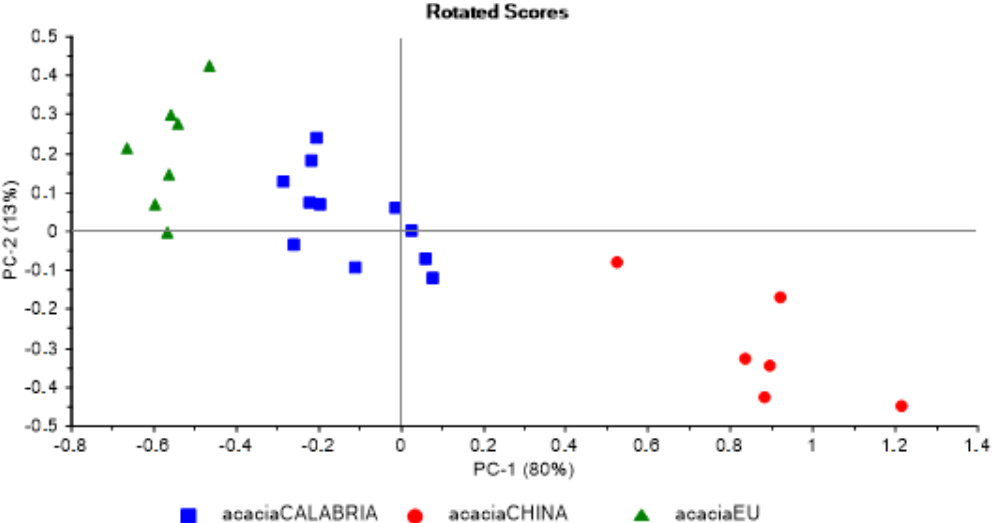
Figure 4. PCA of acacia honeys classified based on geographical origin.